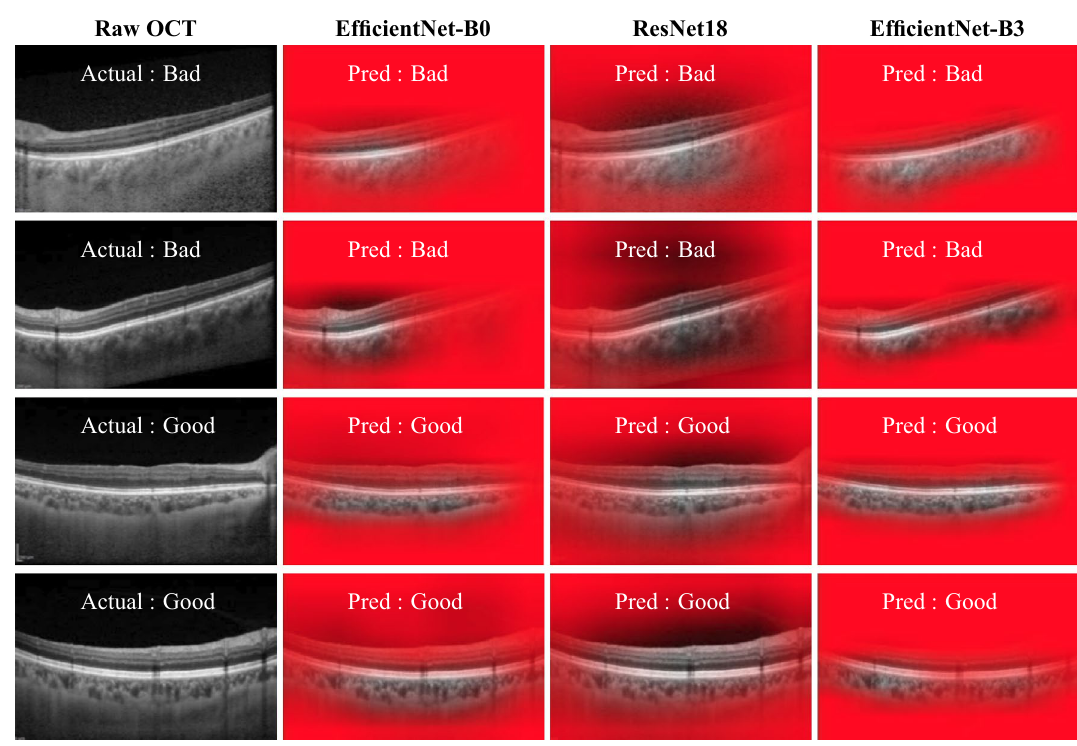
Figure 2. Representative images of OCT images with CTMs corresponding to all three models. While top two rows correspond to bad quality OCT image, the bottom two rows correspond to good quality OCT image. OCC (%) CCVR (%) |OCC-CCVR| (%) ENet-B0 ResNet18 ENet-B3 ENet-B0 ResNet18 ENet-B3 ENet-B0 ResNet18 ENet-B3